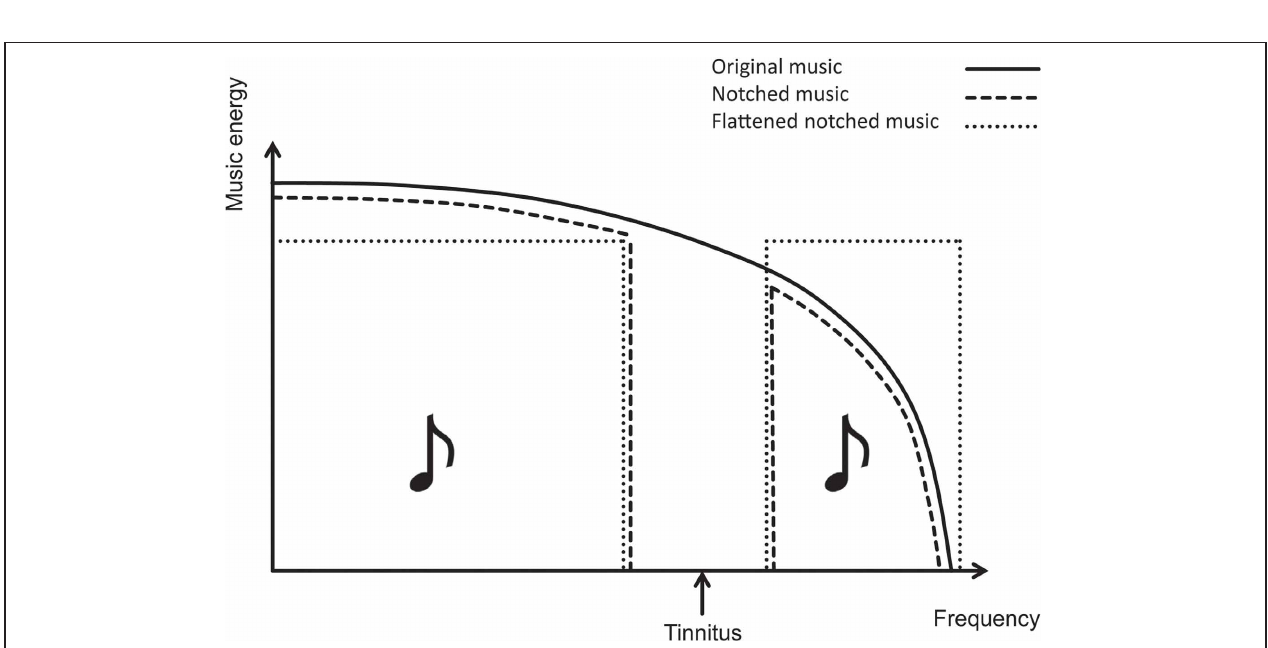
averages and each “ × ” indicates an individual data point. The error bars denote confidence intervals. Auditory steady state response (ASSR) change values are reflected by white bars and N1m change values are reflected by gray bars. As indicated by the confidence interval bars, only the changes in the target group were statistically significant.